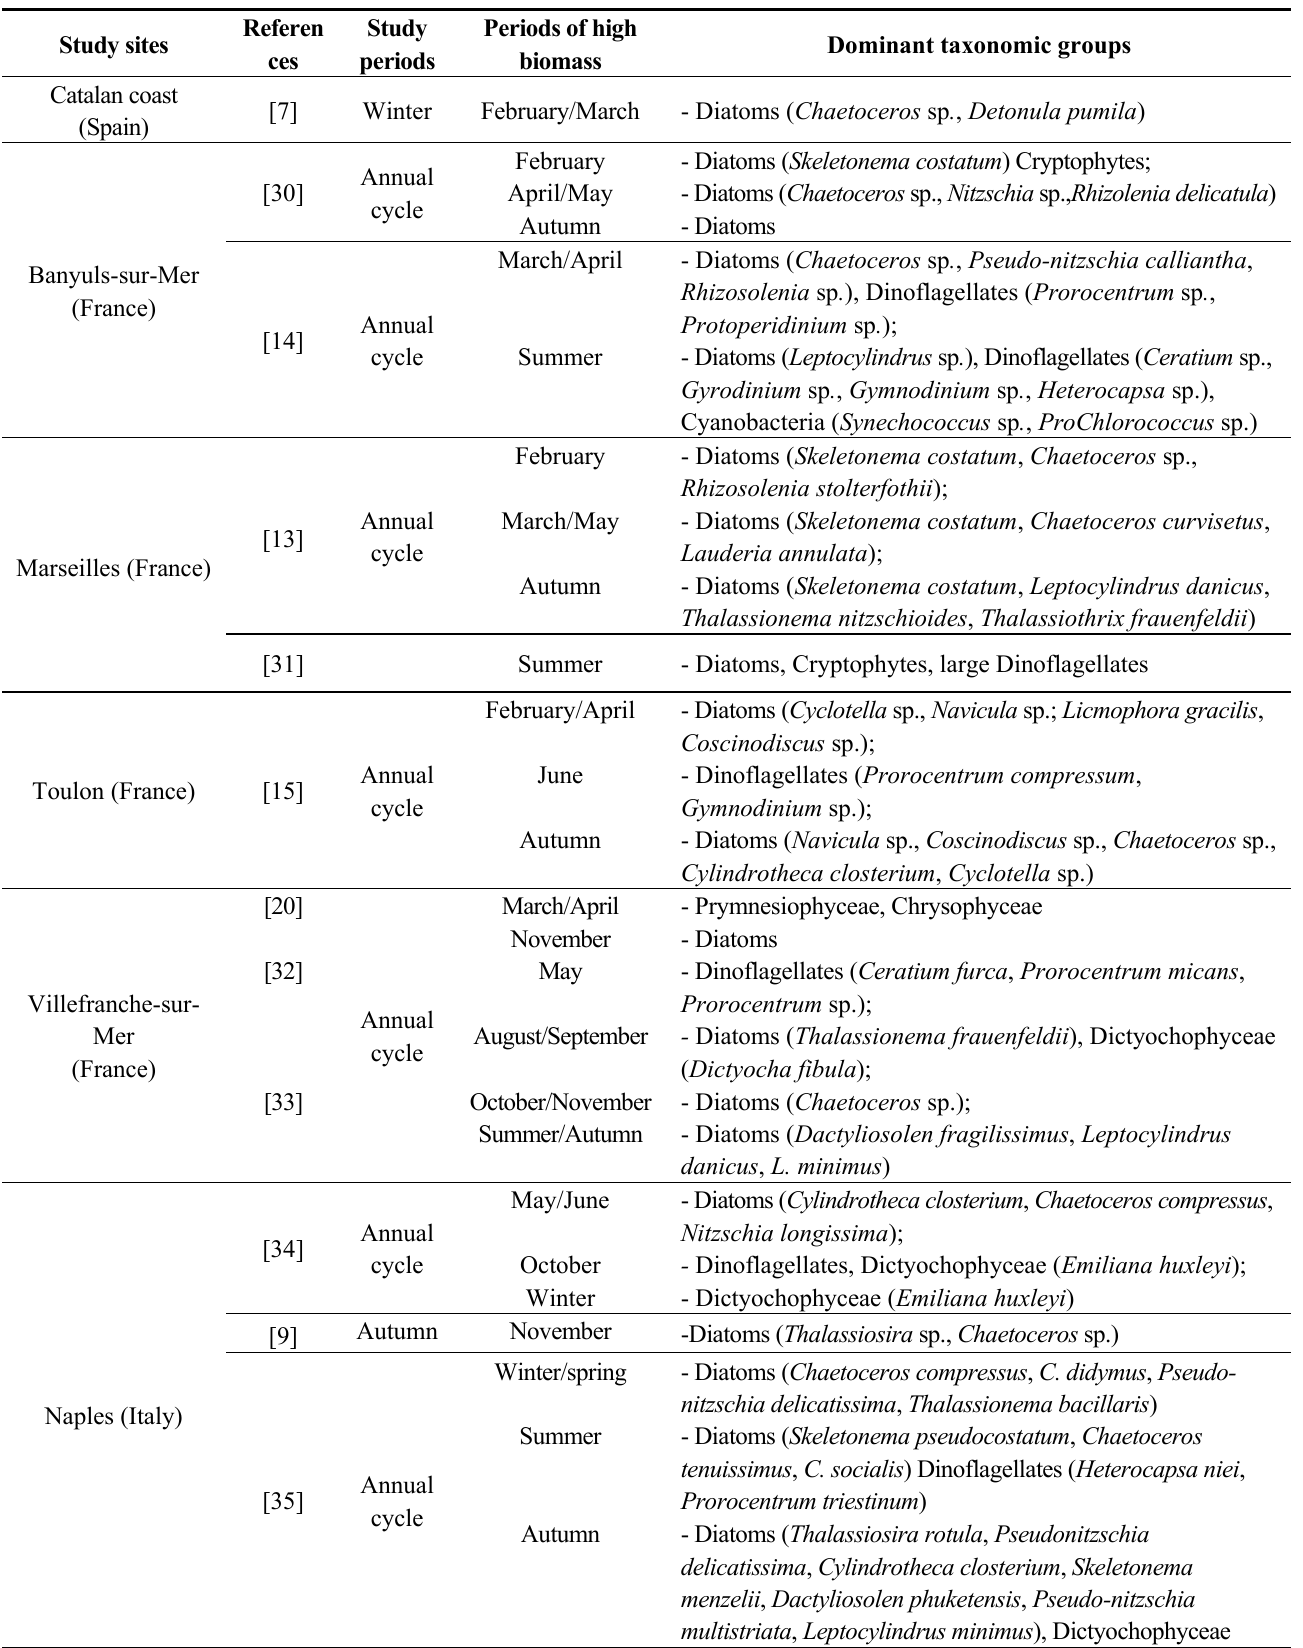
Table 1. A non-exhaustive inventory of phytoplankton variation in coastal ecosystems (NW Mediterranean